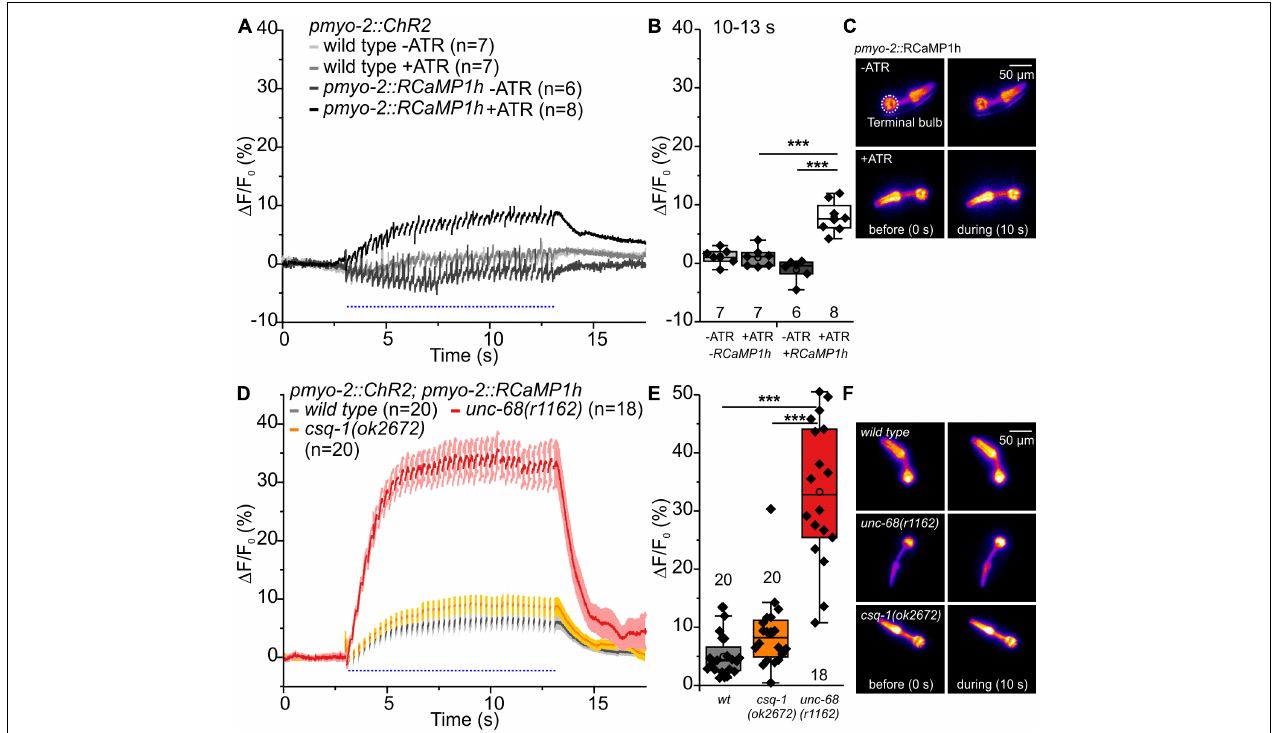
FIGURE 5 | RCaMP1h Ca 2 + imaging in PMC of unc-68 and csq-1 alleles. (A) Increase of (cid:49) F/F 0 during stimulation (4 Hz, 50 ms, 470 nm) and (B) amplitude of (cid:49) F/F 0 during plateau phase (time period: 10-13 s). An increase of (cid:49) F/F 0 (%) upon light stimulation is only present in ChR2 and RcaMP1h co-expressing pharynxes and in the presence of the ChR2 cofactor ATR. (C) False-color representations of fluorescence intensity of ChR2 and RcaMP1h co-expressing pharynxes raised with and without ATR before blue light stimulation (0 s) and during stimulation ( ∼ 10 s). The terminal bulb of the pharynx, which is used for analysis, is labeled with a circle. (D,E) The null allele of unc-68 , but not of csq-1 , leads to an increase of cytosolic Ca 2 + concentration. (F) Exemplary false-color representation of fluorescence intensity. Only worms that were able to follow 4 Hz stimulation have been included for analysis. Depicted is the mean of (cid:49) F/F 0 (%) without (A) or with SEM (D) , time periods ( ∼ 50 ms), including unspecific peaks induced by blue light stimulation are not displayed here for a better outline. Box plots include every data point (rhomb), mean (open circle), and median (line). N-numbers and significance levels (asterisks) are located either below or above the corresponding boxes. One-way ANOVA with the Bonferroni post-hoc test was performed for comparisons of the mean values during the plateau phase of the fluorescence rise (10–13 s): *** P ≤